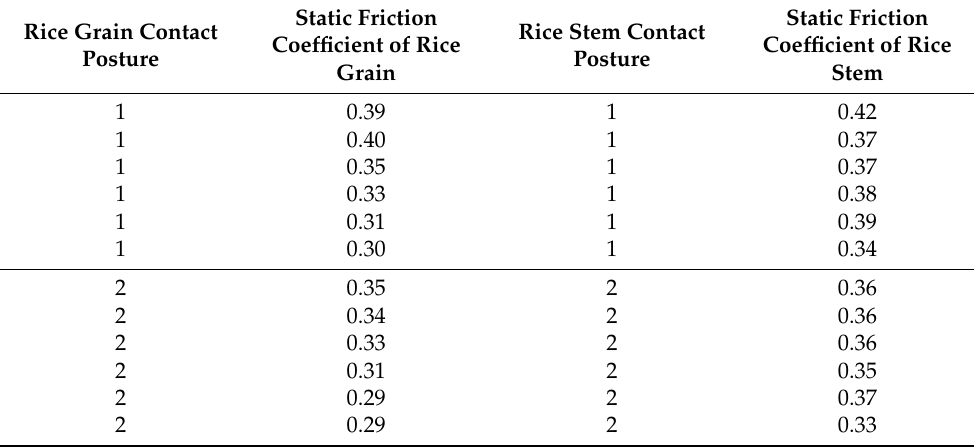
Table 3. Static friction coefficients of the rice grains and stems at all sampling points for different contact